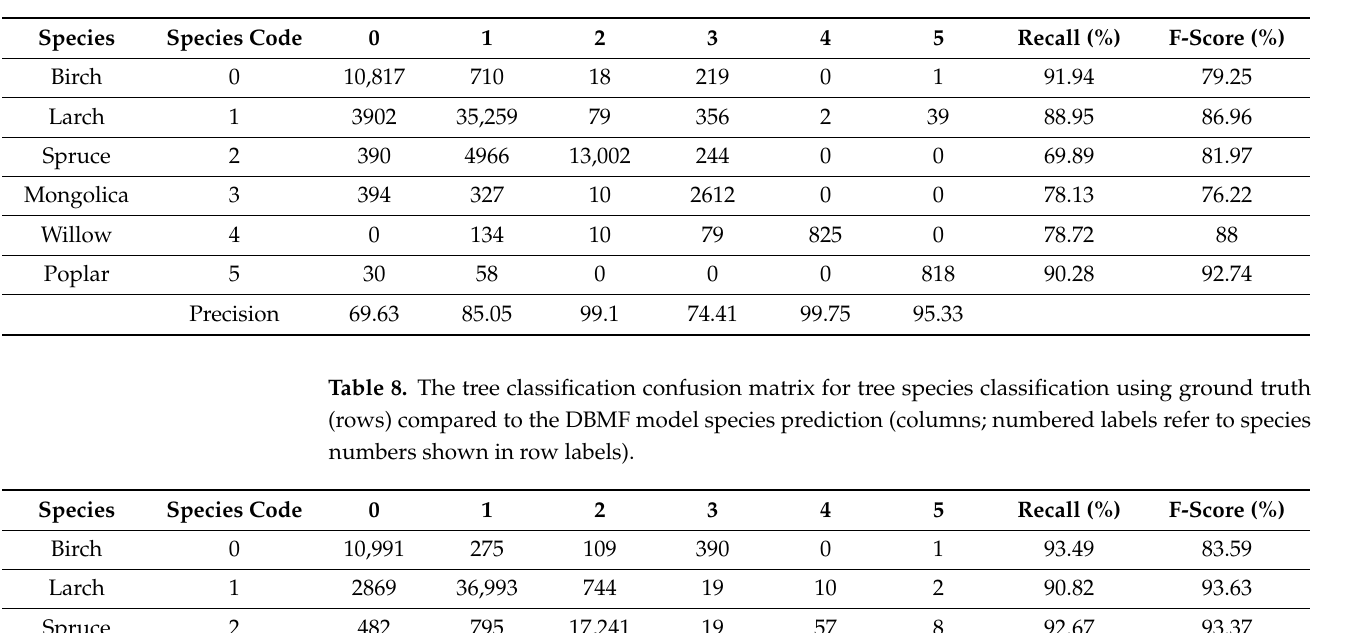
Table 7. The tree classification confusion matrix for tree species classification using ground truth (rows) compared to the DBDA model species prediction (columns; numbered labels refer to species numbers shown in row labels).